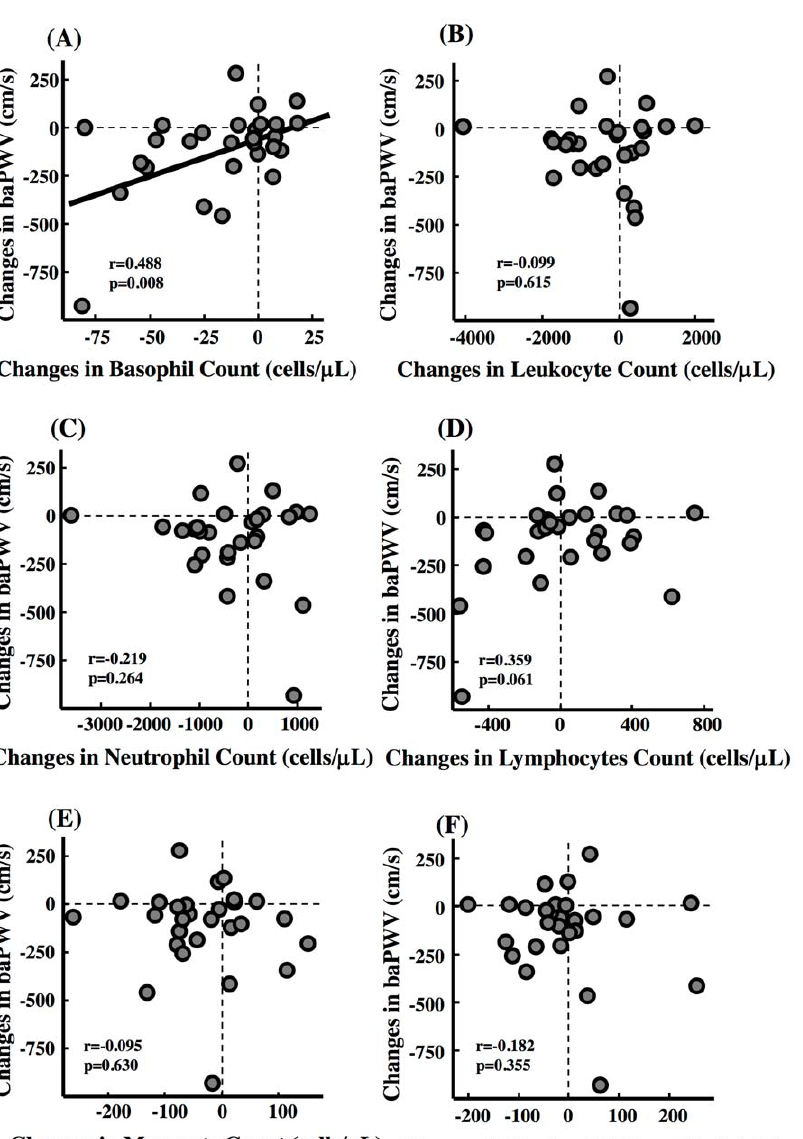
Figure 2. Association Between Arterial Wall Stiffness and Each Plasma Leukocyte. Correlations between changes in brachial and ankle pulse wave velocity (baPWV) and (A) basophil count, (B) total leukocyte count, (C) neutrophil count, (D) lymphocyte count, (E) monocyte count, (F) eosinophil count.